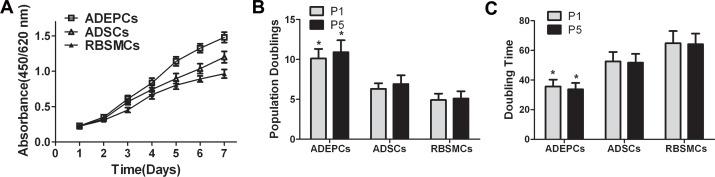
Growth characteristics of ADEPCs, ADSCs and RBSMCs.
(A) Cell proliferation curve showed that all the three kinds of cells had similar growth pattern. (B) The PD at passage 1 and 5 of ADEPCs (10.1±1.2 and 10.9±1.5) were significantly higher than that of ADSCs (6.3±0.7 and 6.9±1.1) and RBSMCs (4.9±0.8 and 5.1±0.9) (*p<0.05, n = 6). (C) The DT at passage 1 and 5 of ADEPCs (35.7±4.6 hours and 33.8±4.2 hours) were significantly lower than that of ADSCs (52.6±6.3 hours and 51.7±5.9 hours) and RBSMCs (64.8±8.2 hours and 64.2±7.1 hours) (*p<0.05, n = 6).